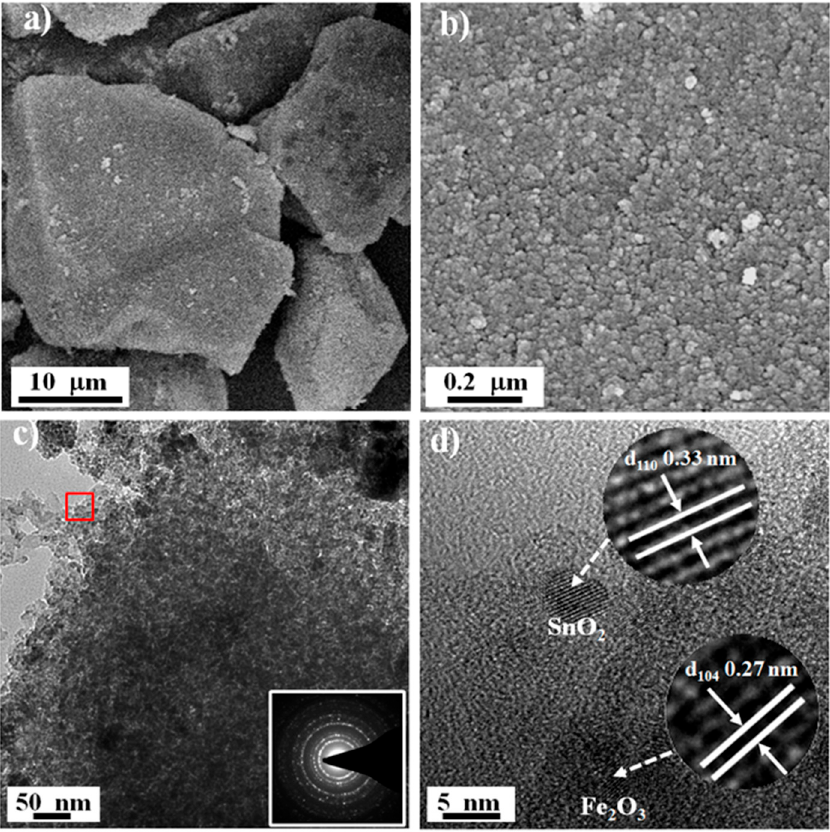
Figure 3. Micromorphology of B-SFO@C sample: ( a ) Low- and ( b ) High-resolution SEM image, ( c ) Low-resolution TEM image and corresponding SAED pattern (inset), ( d ) HRTEM image.